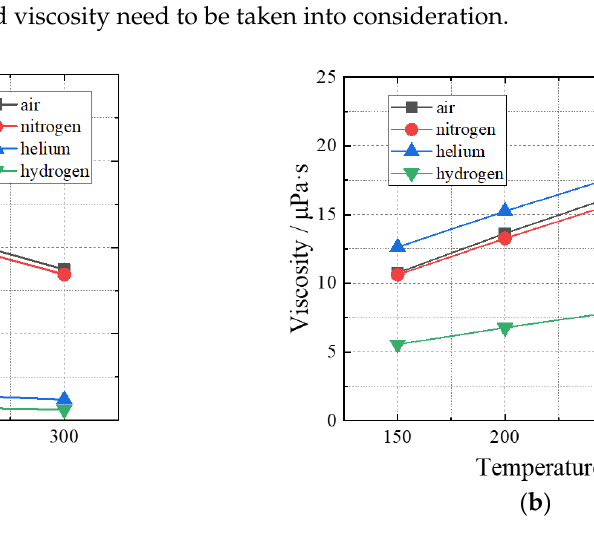
Figure 5. ( a ) Density and ( b ) viscosity of air, nitrogen, helium, and hydrogen with temperature (0.3 MPa).